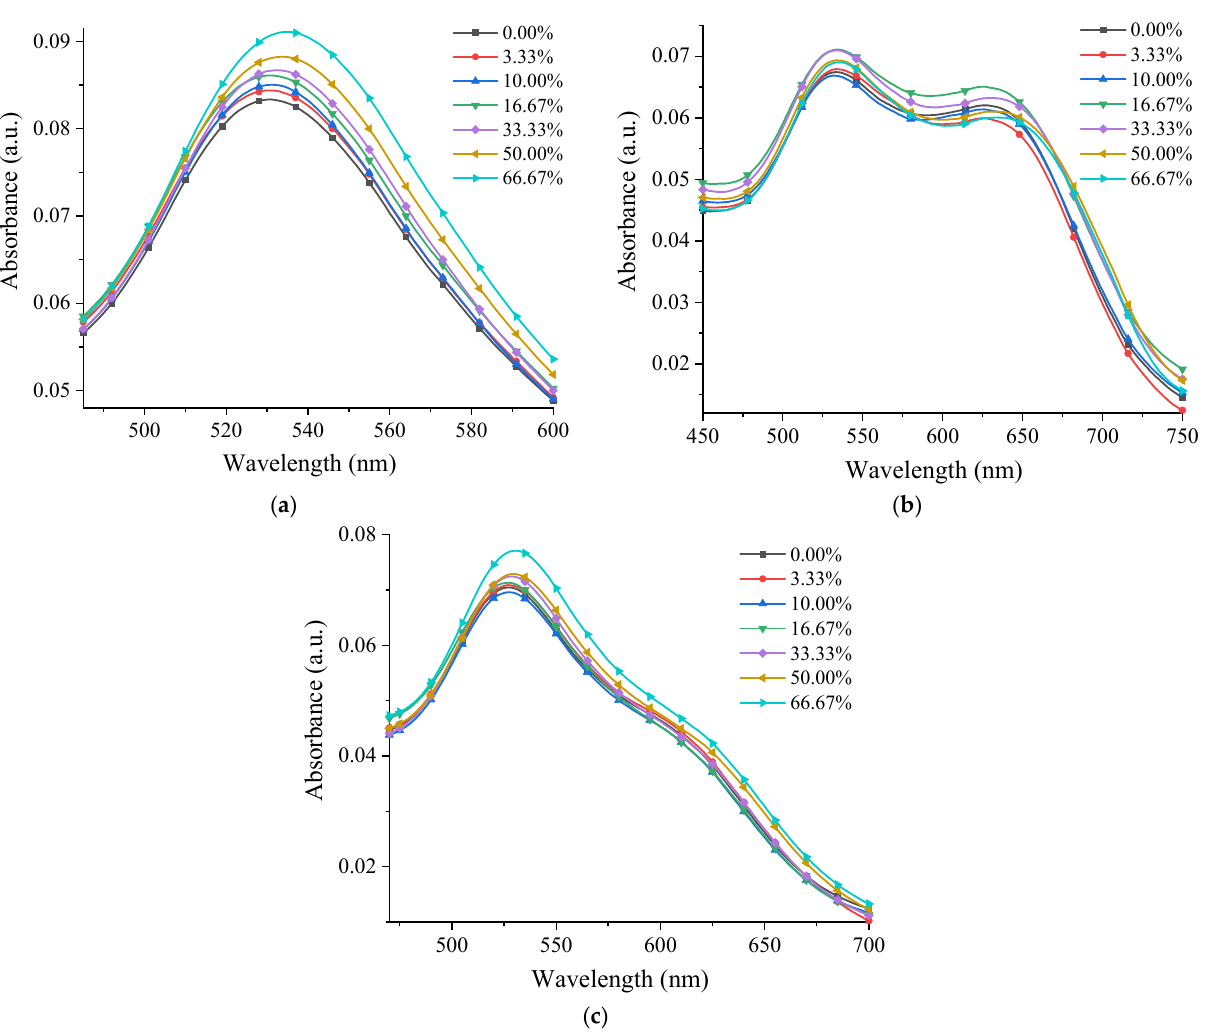
Figure 9. UV-Vis spectra at different glycerol concentrations for the samples: ( a ) P 0.12; ( b ) M 0.12; ( c ) L 0.12.